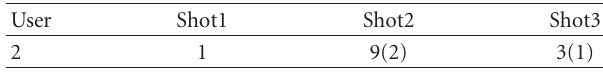
Table 4: Subjective evaluation of Figure